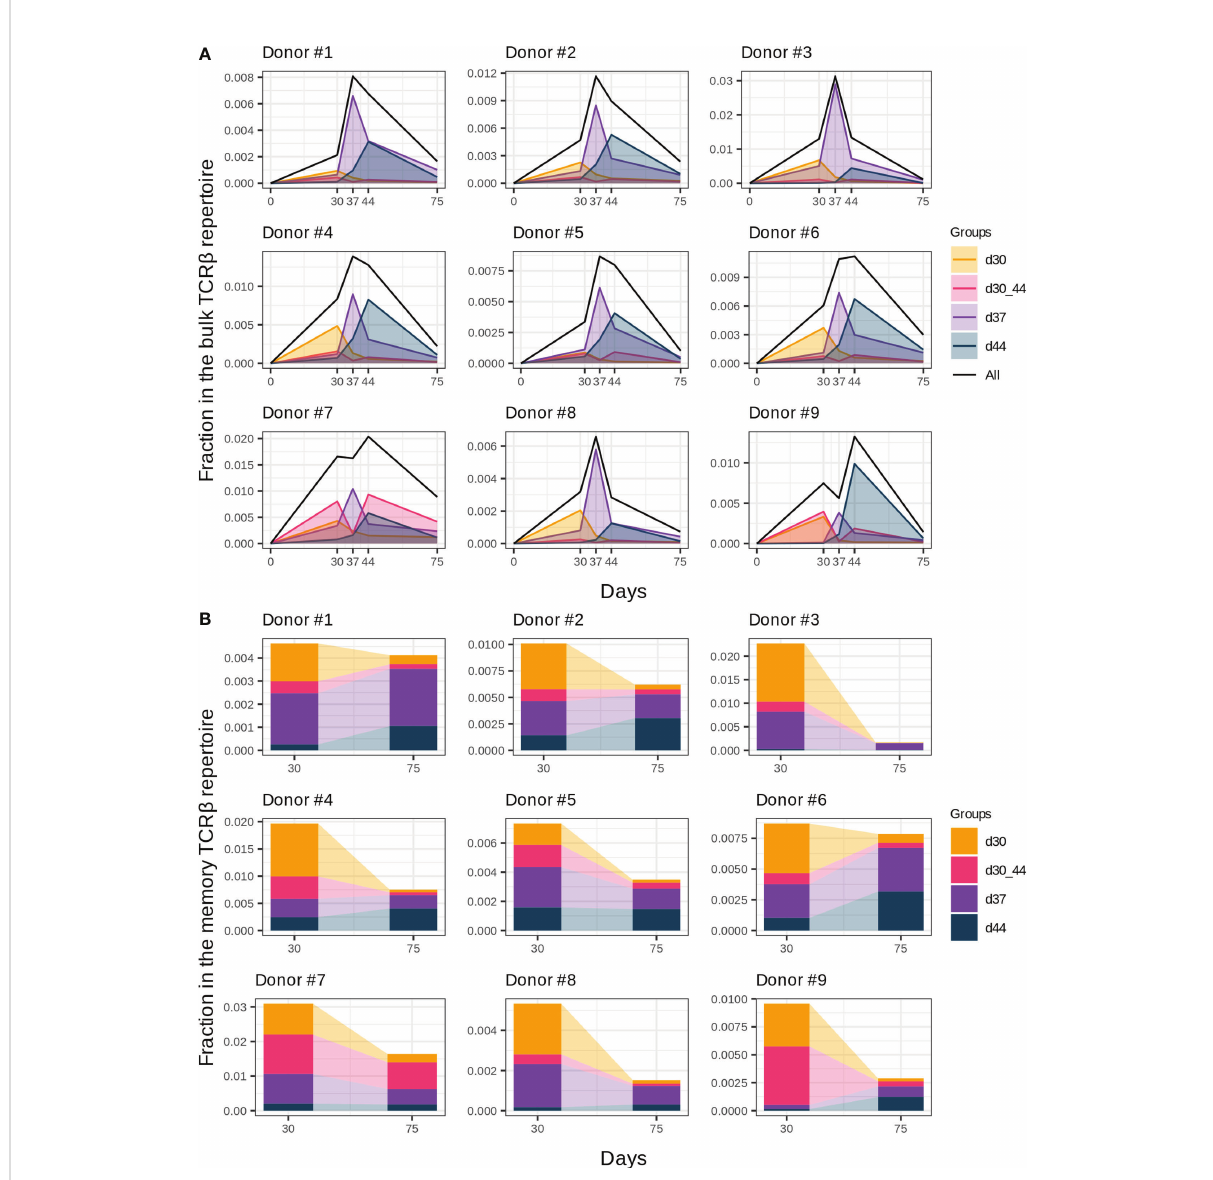
FIGURE 3 Groups of vaccine-associated clonotypes with different dynamics. (A) Dynamics of the responded clonotype fractions in the bulk TCR b repertoire (Figure 2A) formed by clonotypes of groups “ d30 ” , “ d37 ” , “ d44 ” , and “ d30_44 ” . (B) Fractions of clonotype groups in memory T cells on days 30 and 75. Donors #10 and #11 were excluded from analysis because of incomplete sample